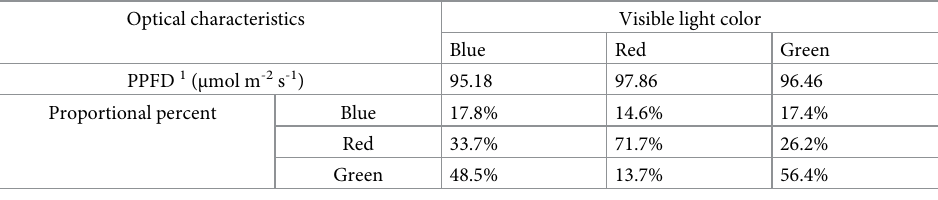
Note: 1 PPFD, photosynthetic photon flux density.